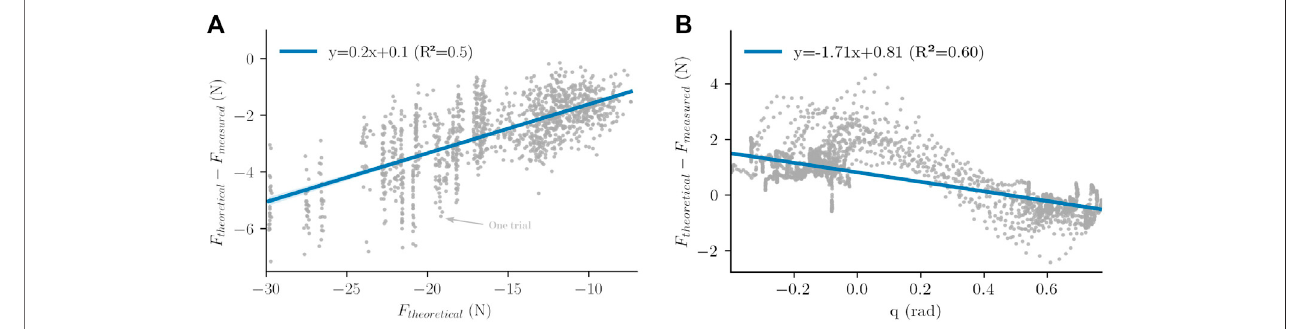
FIGURE 3 | Mean linear models extracted from experiments. (A) Interaction force versus theoretical force and mean linear behavior. (B) Interaction force versus angular position and mean linear